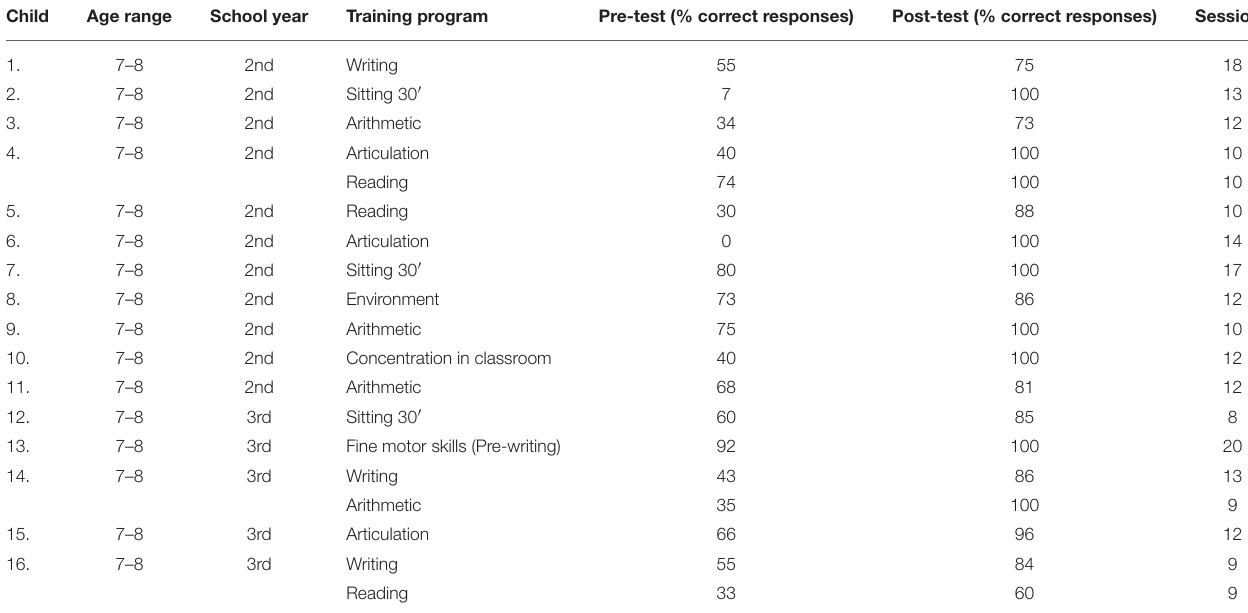
TABLE 4 | Study 1. Children at ISCED 1 trained in the period 2013–2014. Child Age range School year Training program Pre-test (% correct responses) Post-test (% correct